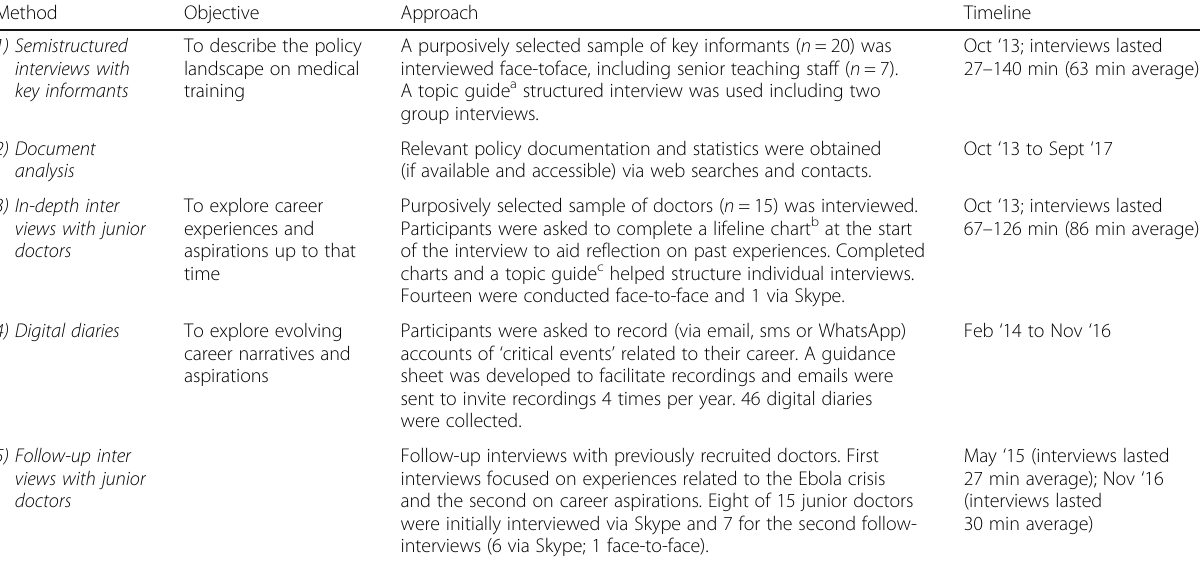
Table 1 Overview of methods applied for larger qualitative longitudinal study